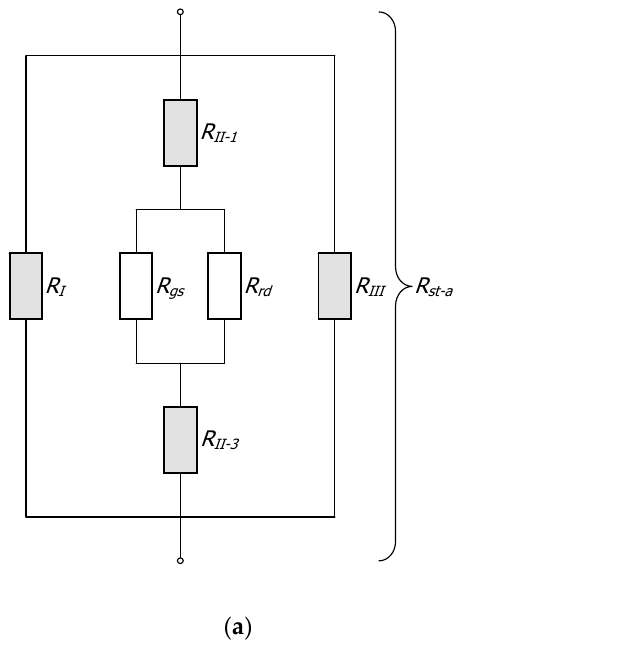
Figure 26. The networks of thermal resistance used for a rectangular section: ( a ) network for R st-a resistance; ( b ) network for R st-b resistance.